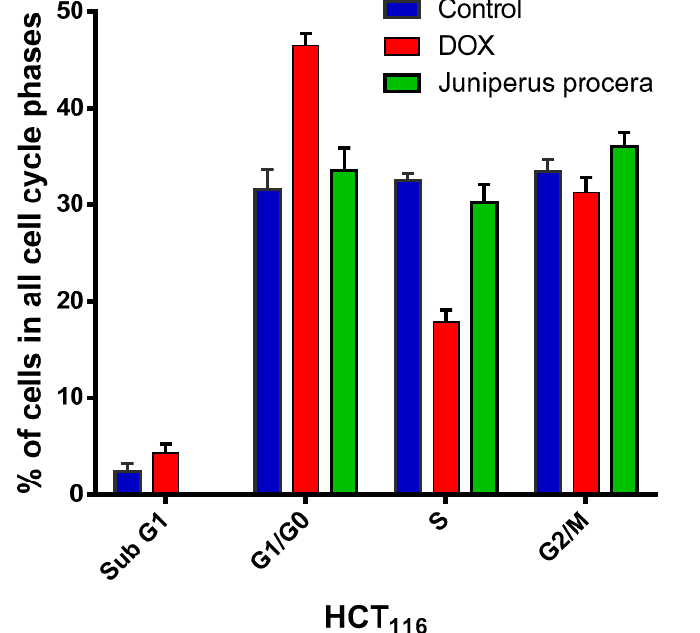
Figure 7. Percentage of cells of HCT 116 treated with DOX and J. procera methanolic extract in all cell-cycle phases. Table 5. Early and late apoptotic percentages in HCT 116 cells treated for 24 h with 3 μ M DOX and J. procera extract. Treatment